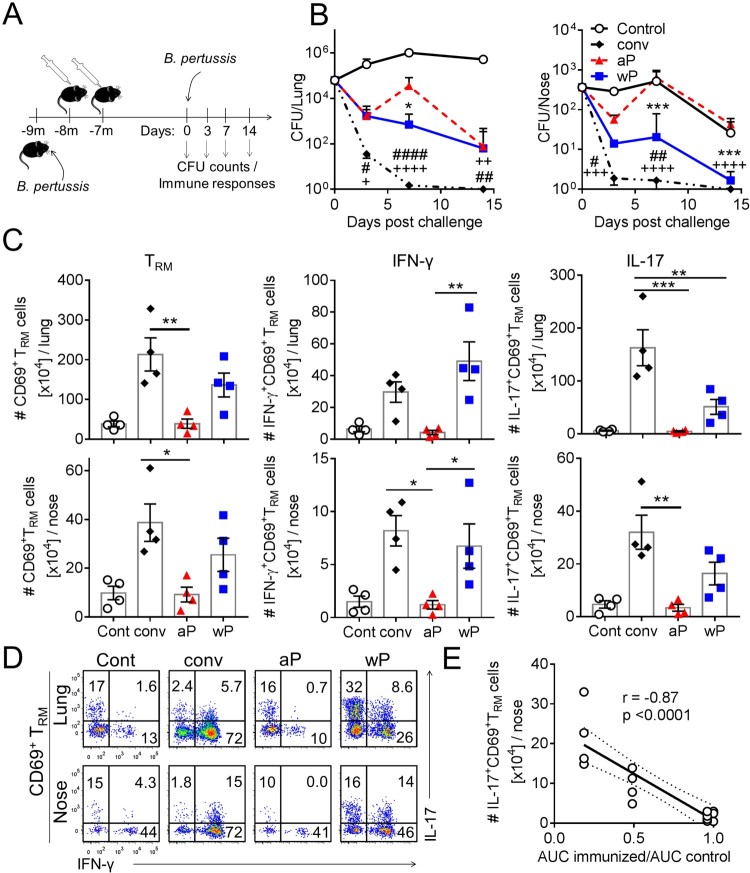
Sustained protective immunity against nasal colonization induced by previous infection or immunization with a wP vaccine correlates with the induction of TRM cells. (a) Schematic of immunization and challenge protocol. C57BL/6 mice were either aerosol infected with B. pertussis (conv), or immunized with 1/50 human dose of aP (Boostrix) or wP (NIBSC) twice at an interval of 4 weeks. Seven months after clearance of primary infection or after the 2nd immunization, the animals were aerosol challenged with B. pertussis. (b) CFUs in lung and nasal tissue homogenates were determined 3, 7, and 14 days post challenge. Results are mean ± SEM n = 4 mice per group per time-point. *p < .05, ***p < .001 aP versus wP; #p < .05, ##p < .01, ####p < .0001 wP versus conv; ++p < .01, +++p < .001, ++++p < .0001 aP versus conv by two-way ANOVA with the Tukey’s post-test. (c) Seven days post challenge, lymphocytes from the lungs and nasal tissue were prepared by digestion. Prior to euthanasia, the animals were i.v. injected with fluorochrome-coupled CD45 antibody to allow the discrimination of tissue-resident and circulating cells. Results are mean ± SEM (n = 4 mice) absolute numbers of CD69+CD4+ TRM cells (left graphs), IFN-γ-producing CD69+ CD4+ TRM cells (middle graphs) and IL-17-producing CD69+CD4+ TRM cells (right graphs) in the lung (top) or nasal tissue (bottom). *p < .05, **p < .01, ***p < .001 by one-way ANOVA with the Tukey’s post-test, only significant differences between experimental groups are indicated. (d) Representative plots showing secretion of IFN-γ and IL-17 by CD45iv–CD44+CD62L–CD69+CD4+ T cells. (e) Correlation between protection against nasal colonization and the absolute number of IL-17-producing CD69+CD4+ TRM cells in that tissue for the corresponding mouse. Protection was expressed as a ratio of the area under the curve (AUC) of bacterial clearance (day 0–14) after challenge of immunized versus the AUC for control unimmunized mice, as previously described [45]. Dotted lines indicate 95% confidence bands of the best fit line.